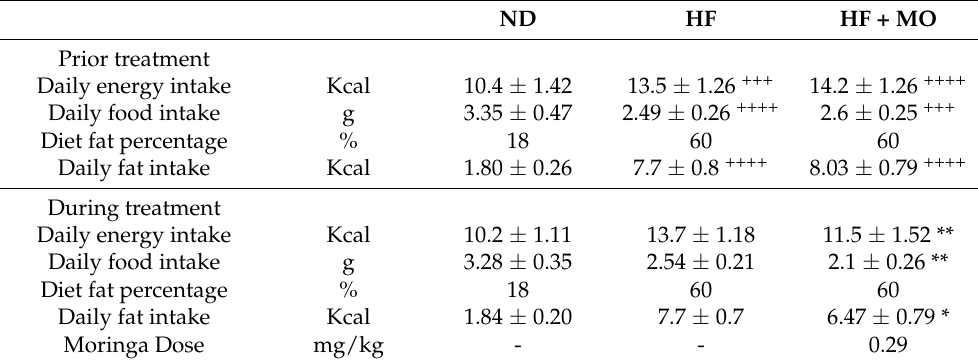
Table 1. Table of dietary intake during the experimental